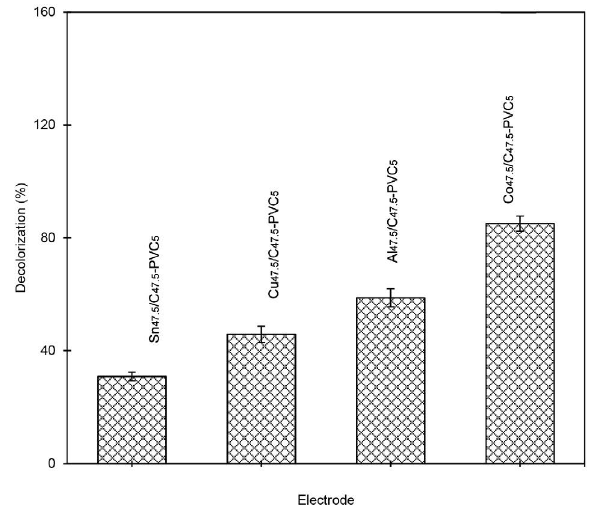
Figure 2. Decolourisation percentage of aqueous RB21 after elec- trolysis by using different types of metal/graphite-PVC composite electrodes. [RB21] o = 50 mg L –1 ; [NaCl] = 1.0 mol L –1 ; E = 5 V; I = 0.62 A; t = 15